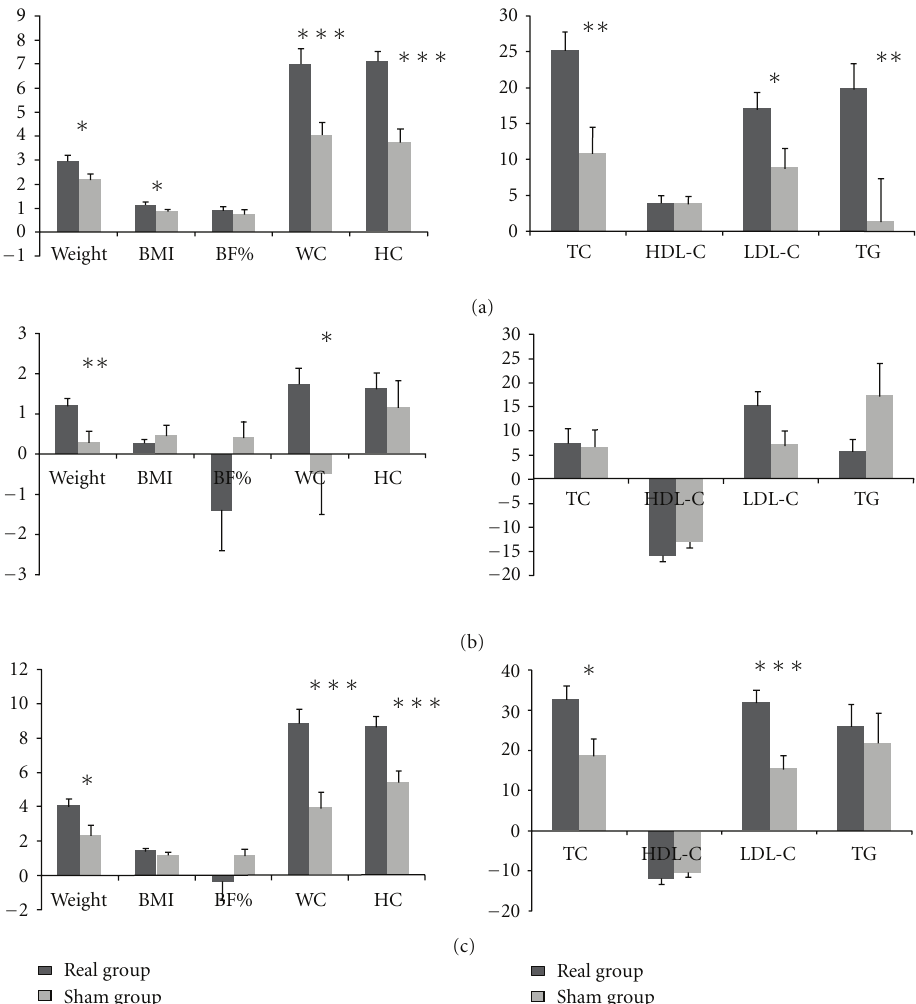
Figure 2: Changes of anthropometric parameters and lipid profile in real and sham groups. BMI: body mass index, BF%: body fat percentage, WC: waist circumferences, HC: hip circumferences, TC: total cholesterol, HDL-C: high density lipoprotein-cholesterol, LDL-C: low density lipoprotein-cholesterol, TG: triglycerides. (a), (b) and (c) means first, second and whole period of the study, respectively, ∗ P < 0 . 05, ∗∗ P < 0 . 01, and ∗∗∗ P < 0 . 001,